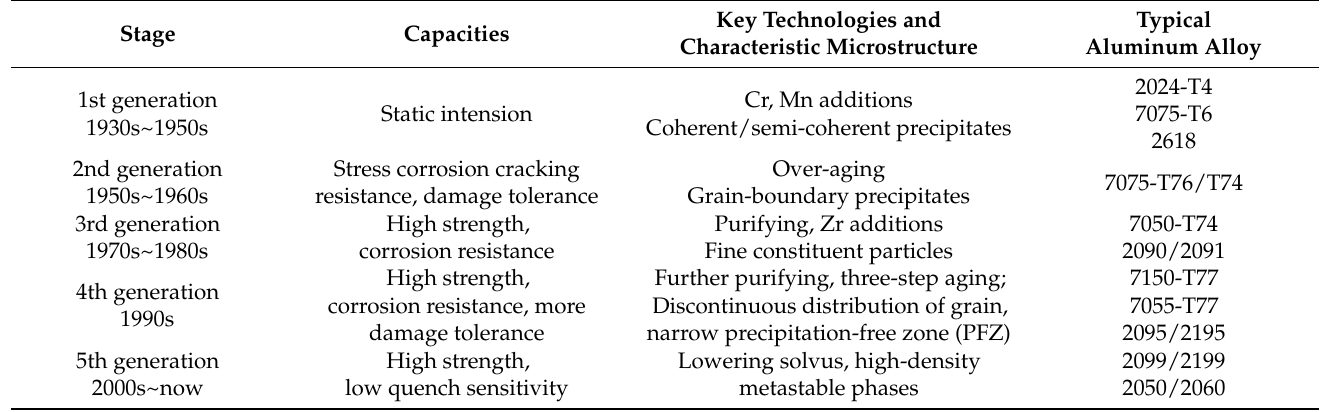
Table 1. Characteristic capacities, key fabrication technologies, and characteristic microstructure of aluminum alloy